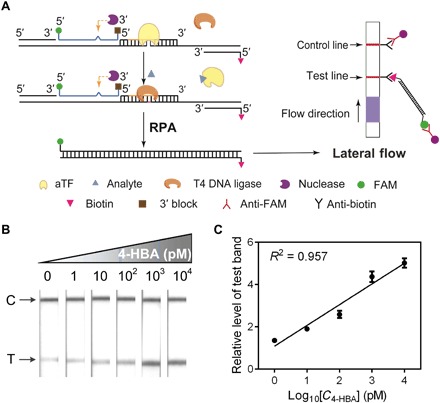
Development of biosensors by coupling aTF-NAST with RPA.(A) Schematic showing strategy of combining aTF-NAST with RPA. (B) LF strip–based detection of different 4-HBA concentrations. C and T indicate the control line and test line, respectively. (C) Calibration curve used to assess the relative intensity of the LF test line signals generated for different concentrations of 4-HBA. Results shown are the relative levels of the gray-scale intensity determined by ImageJ software. The gray scale of the LF test line without 4-HBA (control) was set to a value of 1. FAM, carboxyfluorescein-5-succimidyl ester.